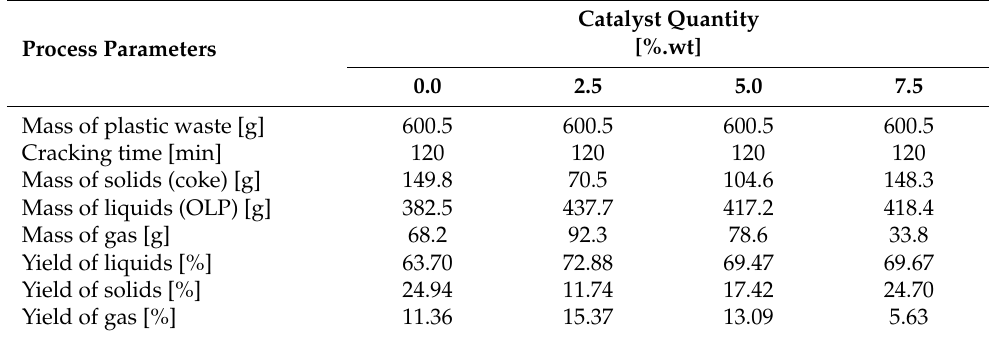
Table 6. Mass balance and yields of reaction products of catalytic upgrading of WEEE plastic